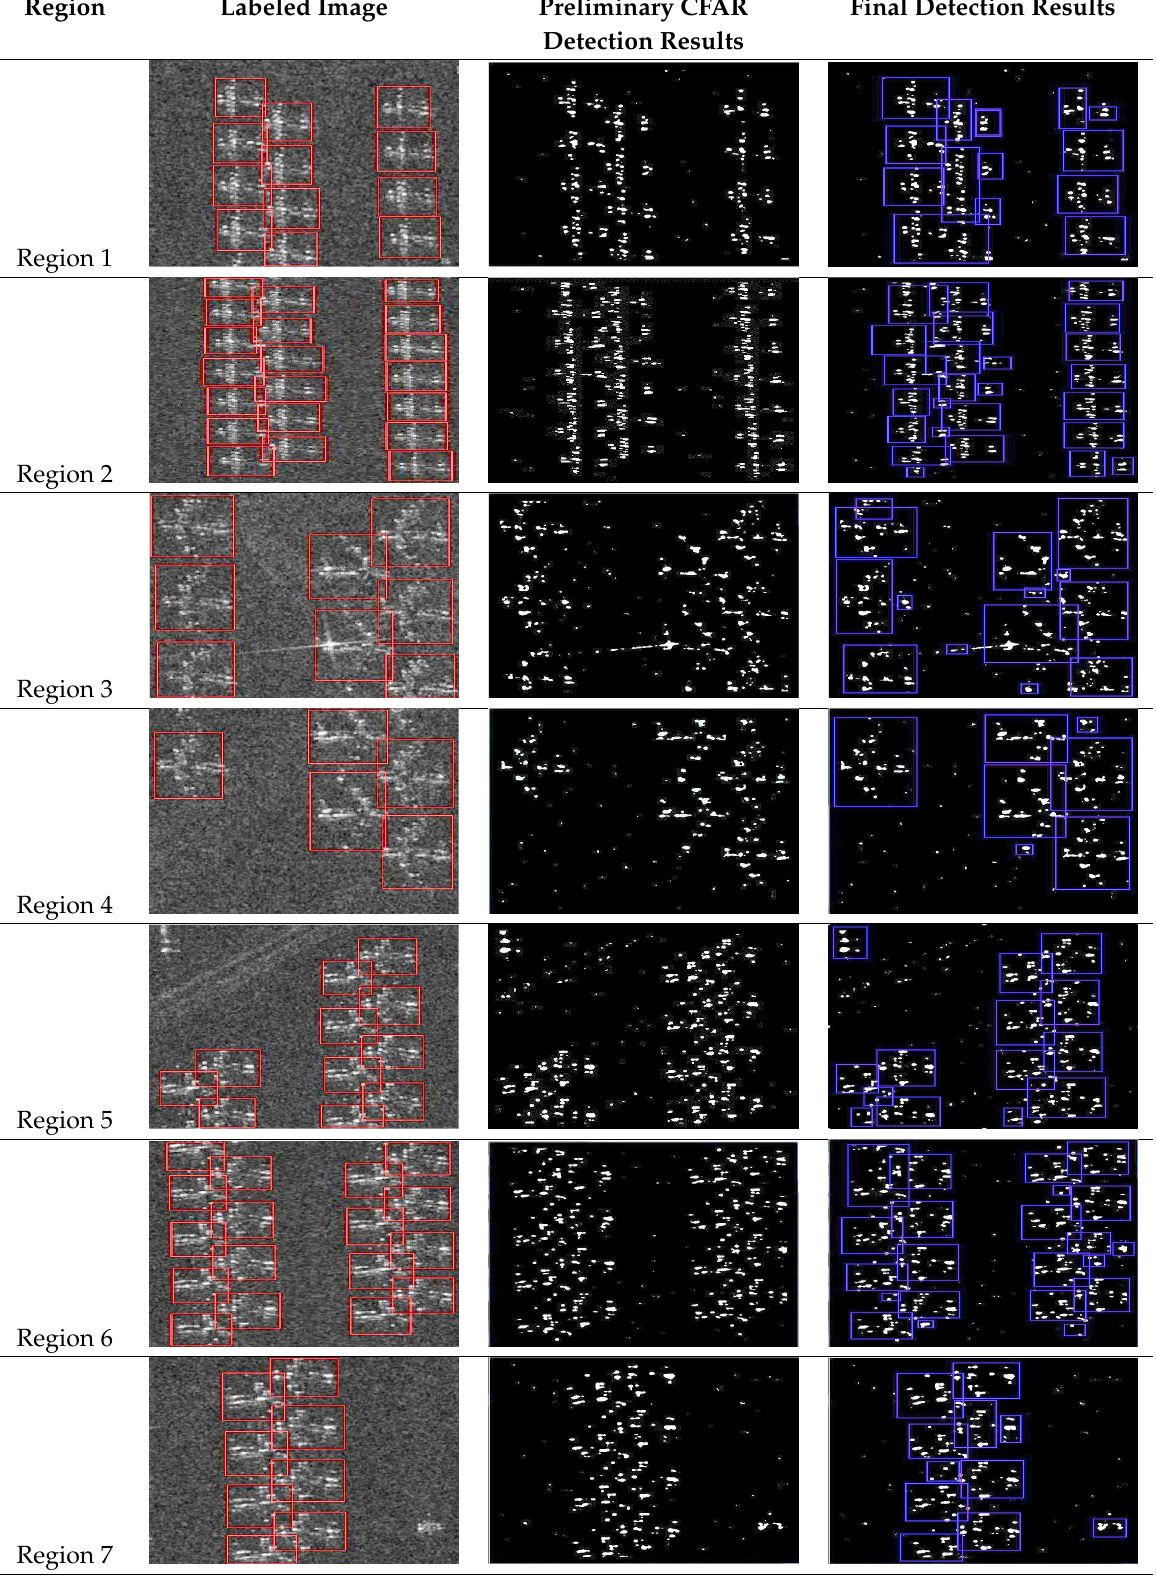
Table 1. Experimental results of constant false alarm rate (CFAR)-based detection